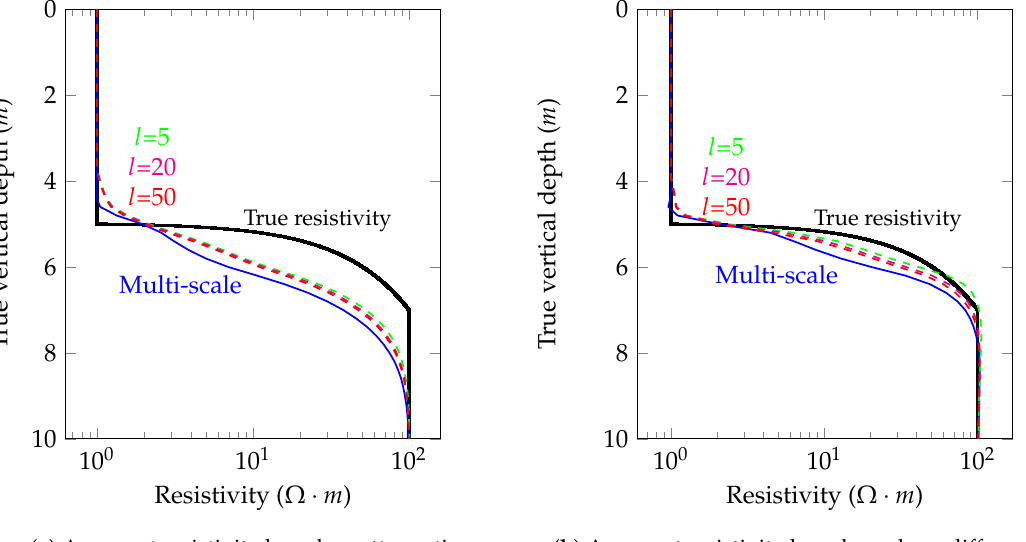
Figure 18. Model problem 3. Convergence of the zz coupling apparent resistivity of the semi-analytic solution to the multi-scale one for a vertical well (dip angle = 0 ◦ ). l is the number of piecewise constant resistivity distributions that we select to approximate the linearly varying